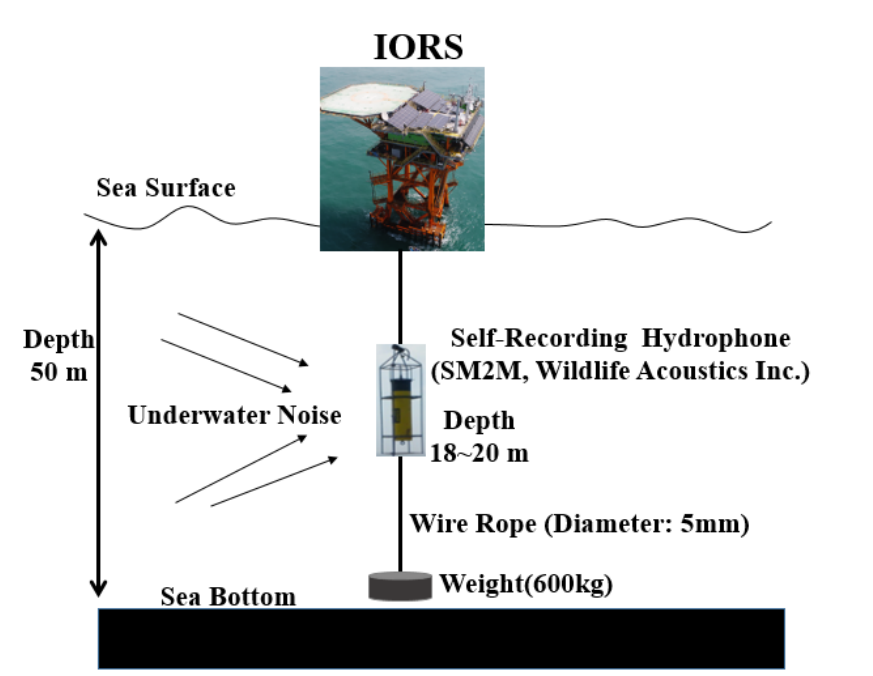
Figure 2. Schematic diagram of the experimental setup used for acoustic measurement of under- water